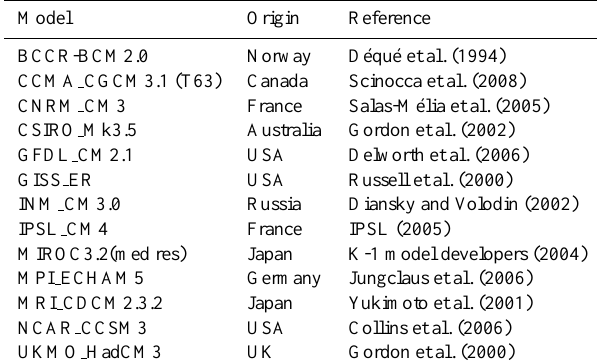
Table 2. List of GCMs and relevant references used in this